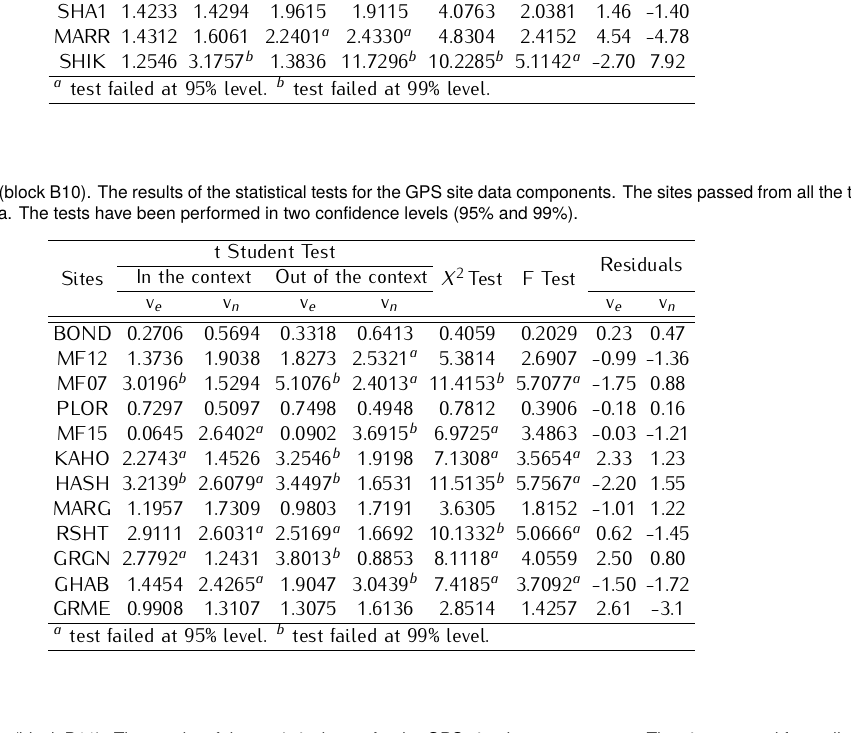
Table 10. Tests results (block B11). The results of the statistical tests for the GPS site data components. The sites passed from all the tests are the accepted data. The tests have been performed in two confidence levels (95% and